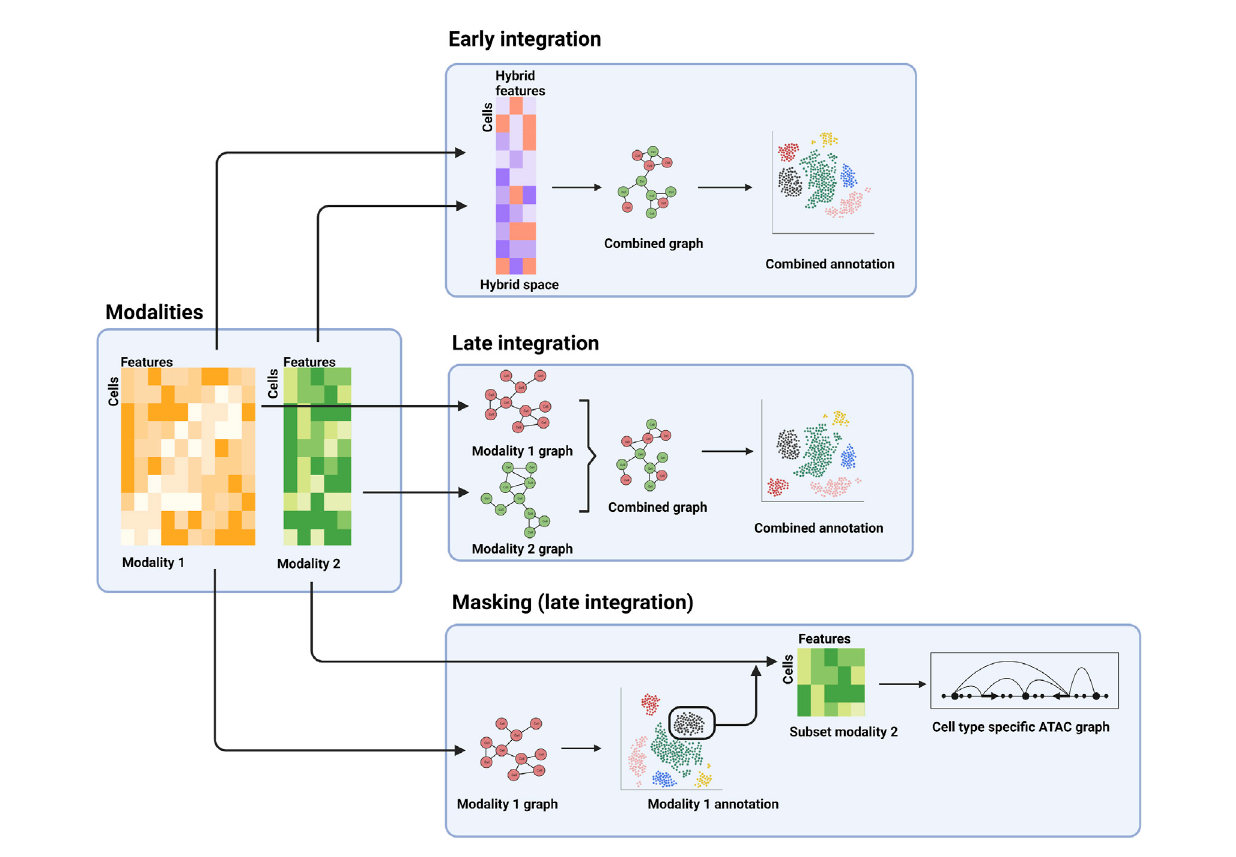
FIGURE 2 Examples of different stages of integration. The separate modalities (left panel) can be combined into a hybrid space for downstream analysis (top panel),processedseparatelyandcombinedfurtherdownstream(middle-rightpanel),orthe fi rstmodalitycanbeusedforacelltype-speci fi canalysisofa second